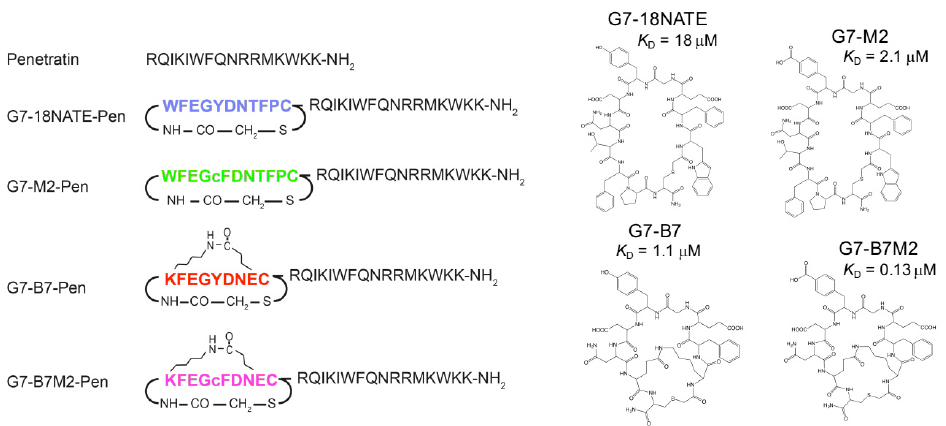
Figure 1. Schematic representation of peptides used in this study. G7-18NATE, G7-B7, G7-B7M2, and G7-M2 Pen-linked peptides are represented schematically alongside Pen on the LHS with single letter codes representing the amino acids and lactam and thioether linkages indicated with a chemical representation. The chemical structure of the peptides are shown on the RHS, along with the affinity of interaction ( K D in units of μ M) of each of these peptides for the Grb7-src homology (SH2) domain previously determined in vitro. Naming guide: “G7” refers to Grb7 target peptides; “M2” refers to the incorporation of the carboxyphenylalanine (cmF) phosphotyrosine mimetic; “B7” refers to the seventh, and highest affinity, bicyclic peptide to be developed.